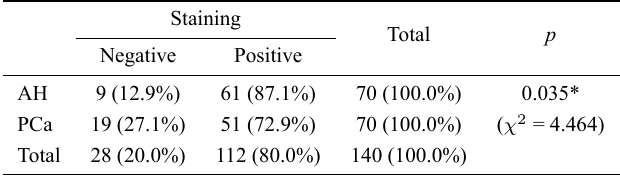
Table 1. Frequency distributions of patients according to WWOX staining results.